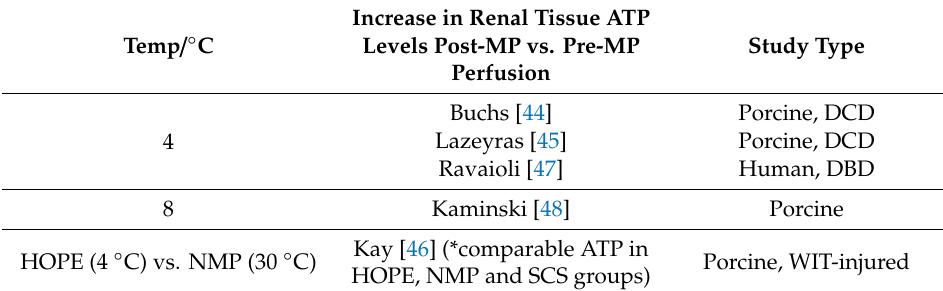
Table 12. MP studies that reported tissue ATP in kidneys (2009–2019).